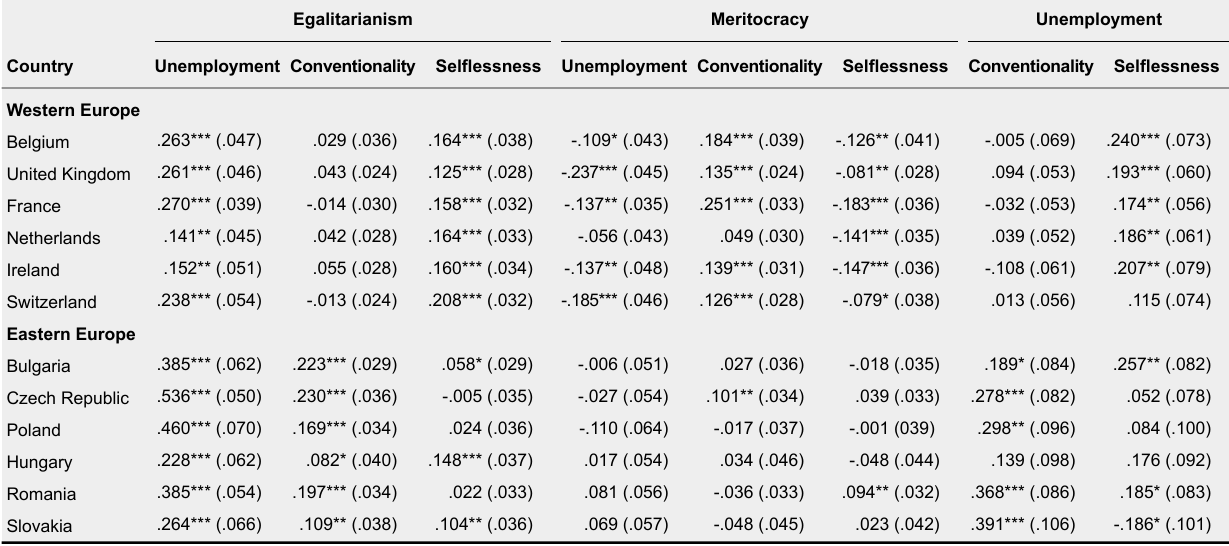
Regression Coefficients of Pathway Models Explaining Support for Unemployment Benefits Based on National